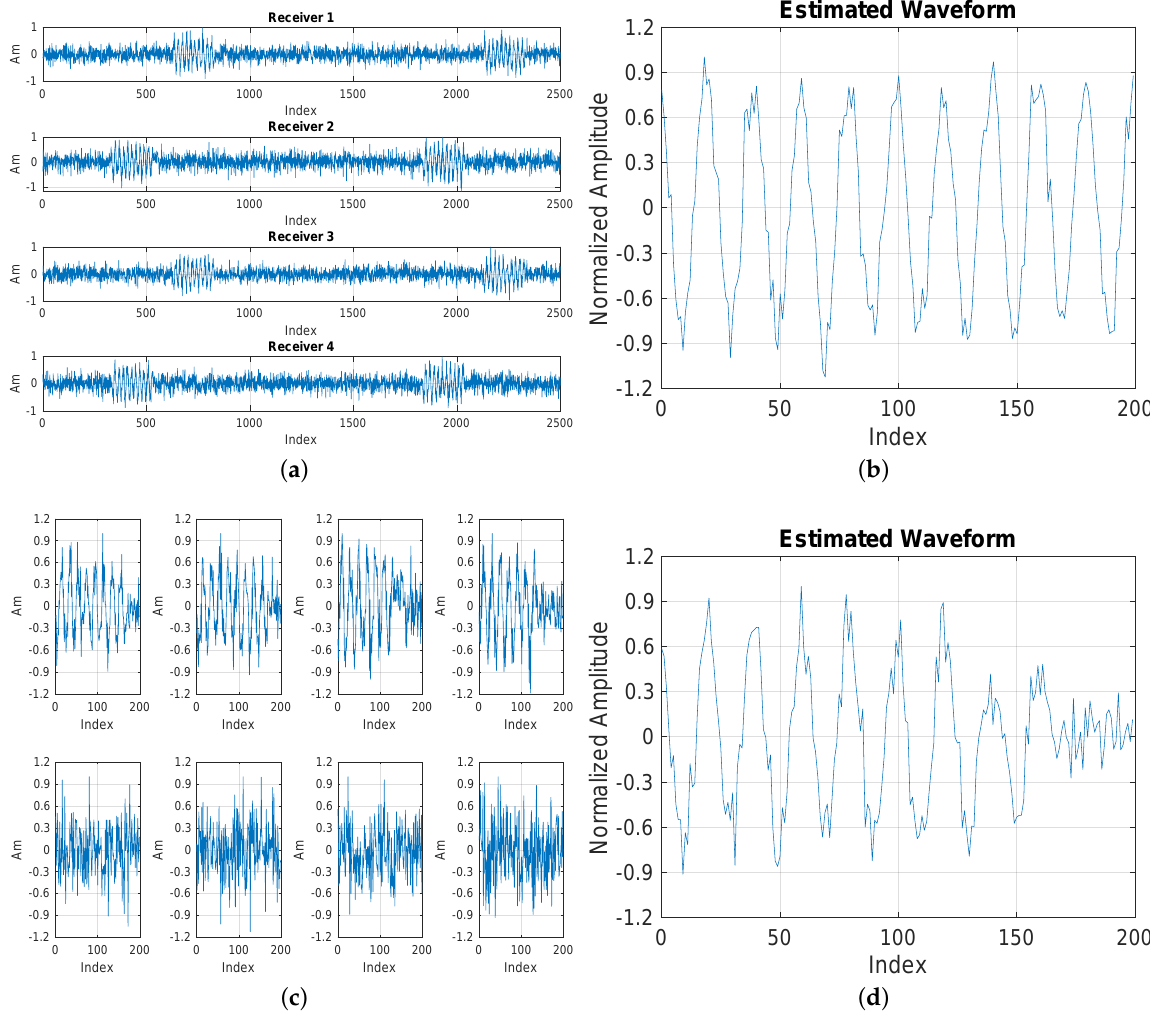
Figure 4. The estimation results of the transmitted Gaussian waveform at the completely correct hypothetical θ and a wrong hypothetical θ for all pulse pair signals with T p = 20 µ s and T r = 150 µ s. ( a ) All received signal measurements with two pulses at SNR 5 dB. ( b ) Estimate of the waveform at the correct hypothetical θ . ( c ) All intercepted pulses corresponding to a wrong hypothetical θ . ( d ) Estimate of the waveform at the wrong hypothetical θ